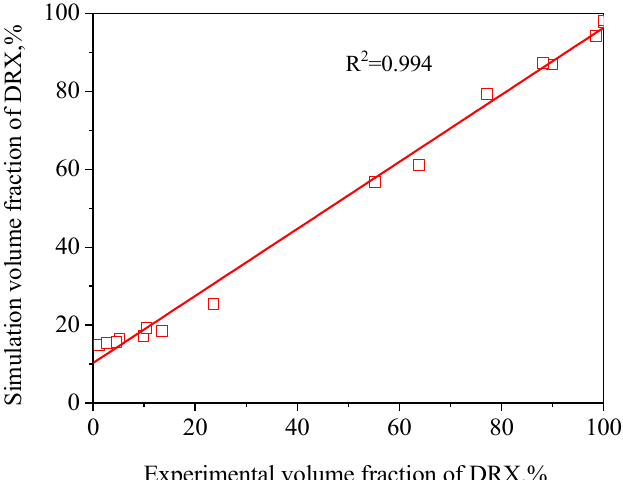
d for TB8 titanium alloys after DRX